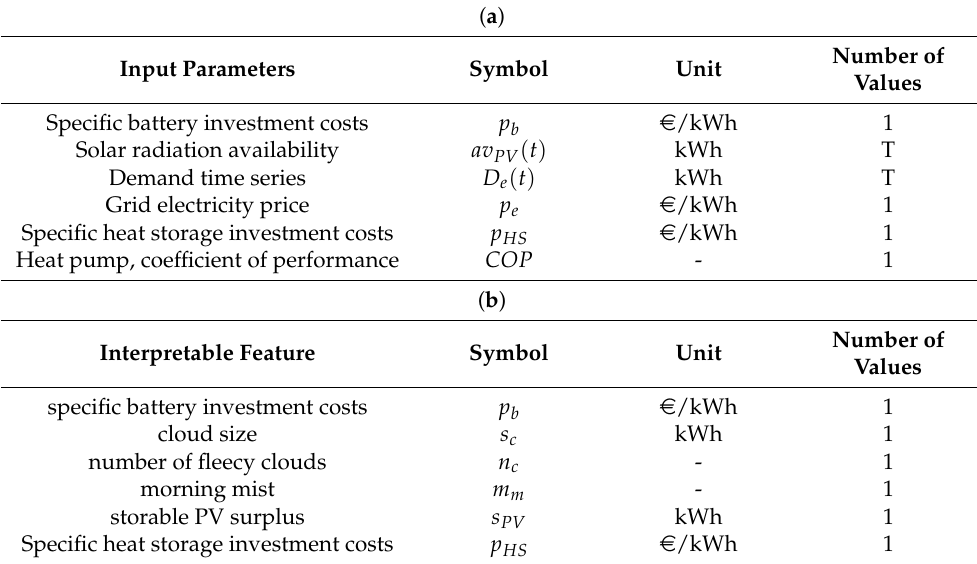
Table 1. ( a ): Inputs of the exemplary building energy system. Time-dependent parameters are vectors with entries for every modeled time step. This model needs a total of 2 T + 4 values as its input, with T as the number of time steps. ( b ): The six interpretable features for explaining the cost-optimal battery capacity of the exemplary building energy